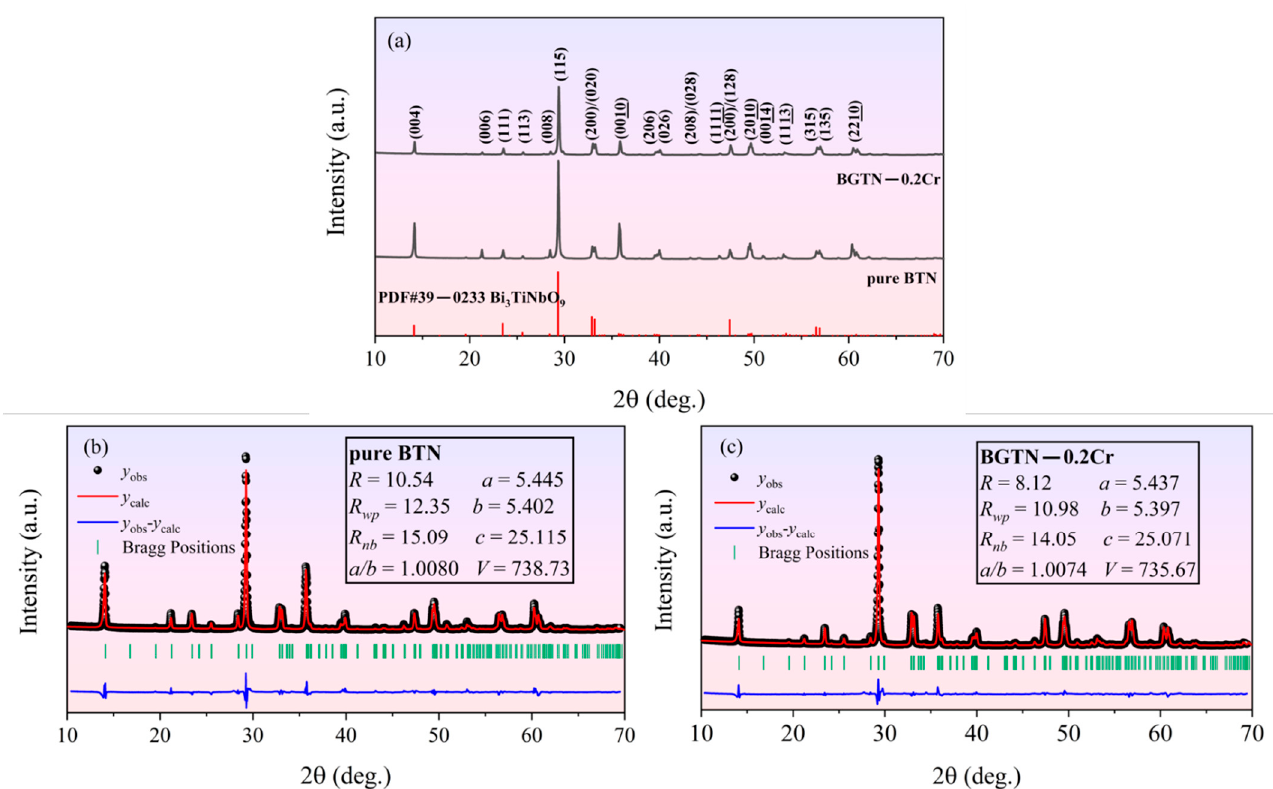
Figure 1. XRD analysis of the sintered ceramics: ( a ) observed XRD patterns of the pure BTN ceramic and the BGTN − 0.2Cr ceramic; ( b ) Rietveld XRD refinement of the pure BTN ceramic; ( c ) Rietveld XRD refinement of the BGTN − 0.2Cr ceramic.